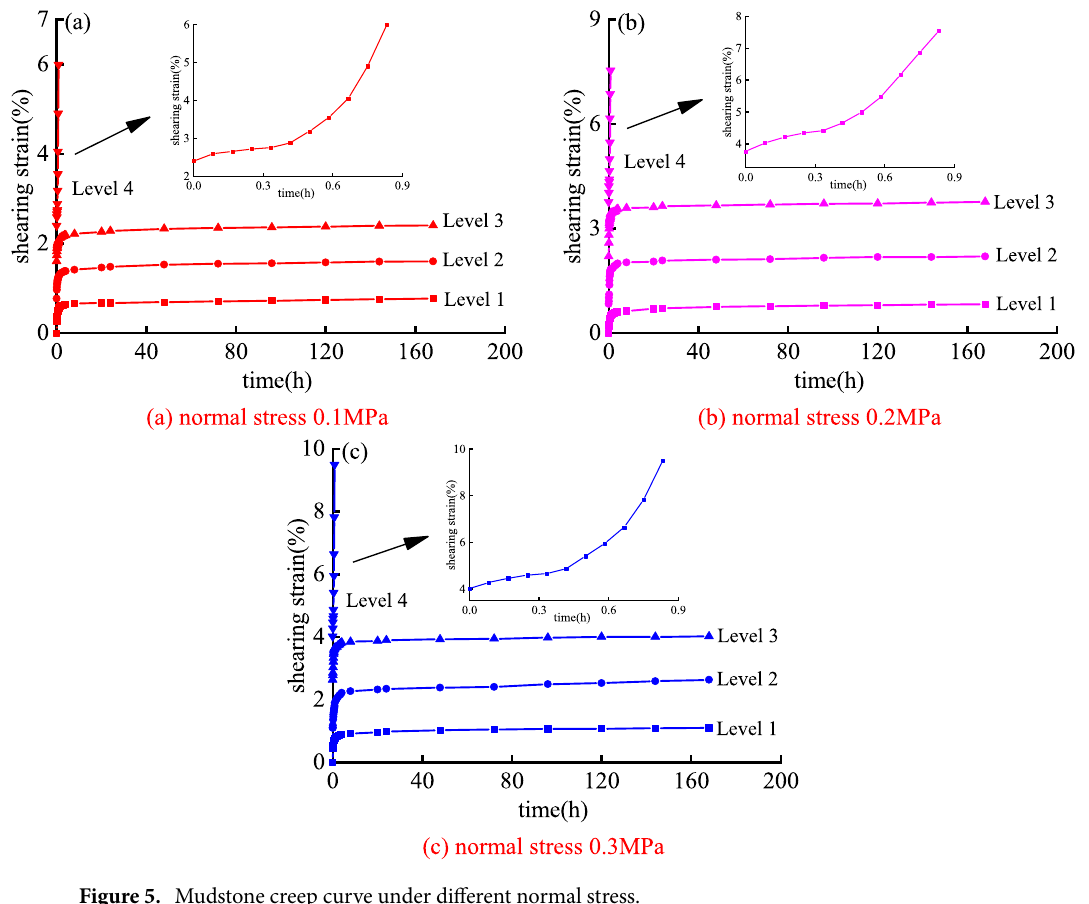
Figure 5. Mudstone creep curve under different normal stress.